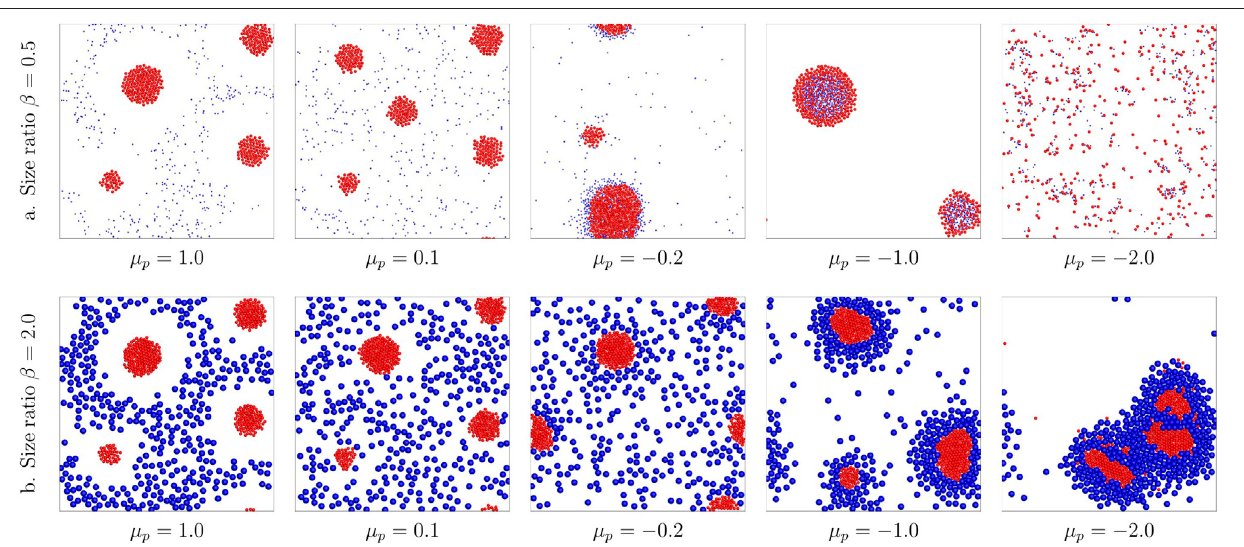
FIGURE 4 | Comparison of binary structures formed by different size ratios β = 0.5, 2.0 with varying passive colloid mobilities ~ μ p from 1.0 to − 2.0. (A) β = 0.5; the binary structure varies from a school of active colloids with exclusion zone at ~ μ p (cid:1) 1 . 0, active cluster core with passive gas phase at ~ μ p (cid:1) 0 . 2, yolk/shell structure with trappedpassivecolloidsat ~ μ p (cid:1) − 0 . 2,passivecolloidsentertheactiveclustersat ~ μ p (cid:1) − 1 . 0anddynamicalactivemoleculesat ~ μ p (cid:1) − 2 . 0. (B) β =2.0;thebinarystructure varies from a school of active colloids with exclusion zone at ~ μ p (cid:1) 1 . 0, active cluster core with passive gas phase at ~ μ p (cid:1) 0 . 2, yolk/shell structure with trapped passive colloids at ~